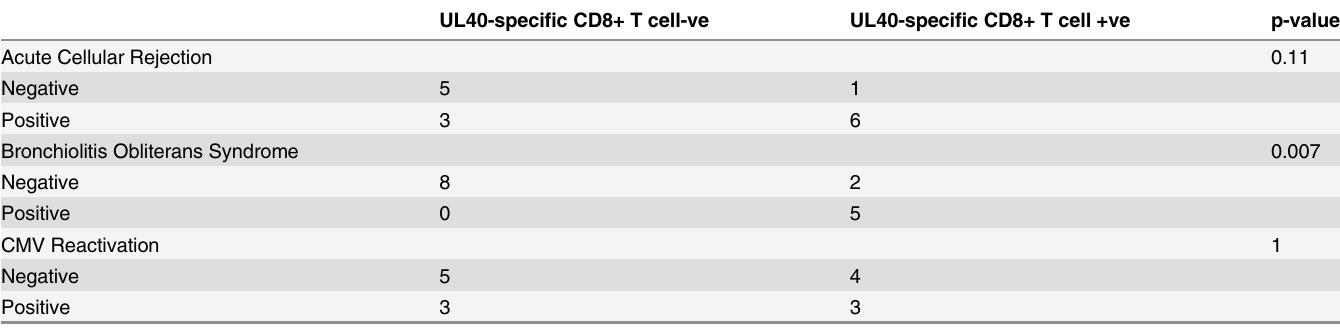
Table 3. Post-transplant * UL40-specific CD8+ T cells: Clinical